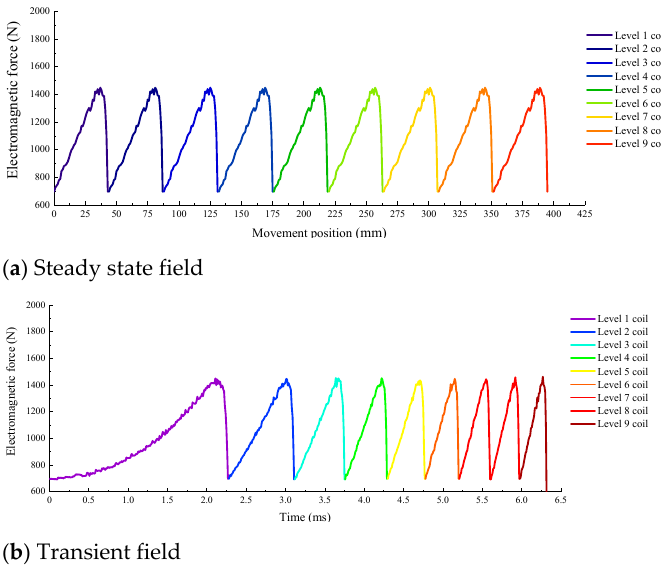
Figure 10. The electromagnetic force of the 45 mm continuous acceleration